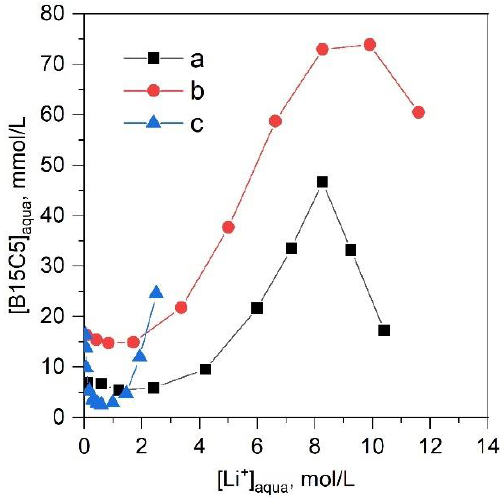
Figure 3. Transition of extractant to the aqueous phase in extraction systems; (a) LiCl-B15C5-CHCl 3 , (b) LiCl-B15C5-[C8mim][NTf 2 ], (c) LiNTf 2 -B15C5-[C8mim][NTf 2 ]. C 0B15C5 = 0.5 mol/L, O/A = 1, T = 23 ± 2 °C.